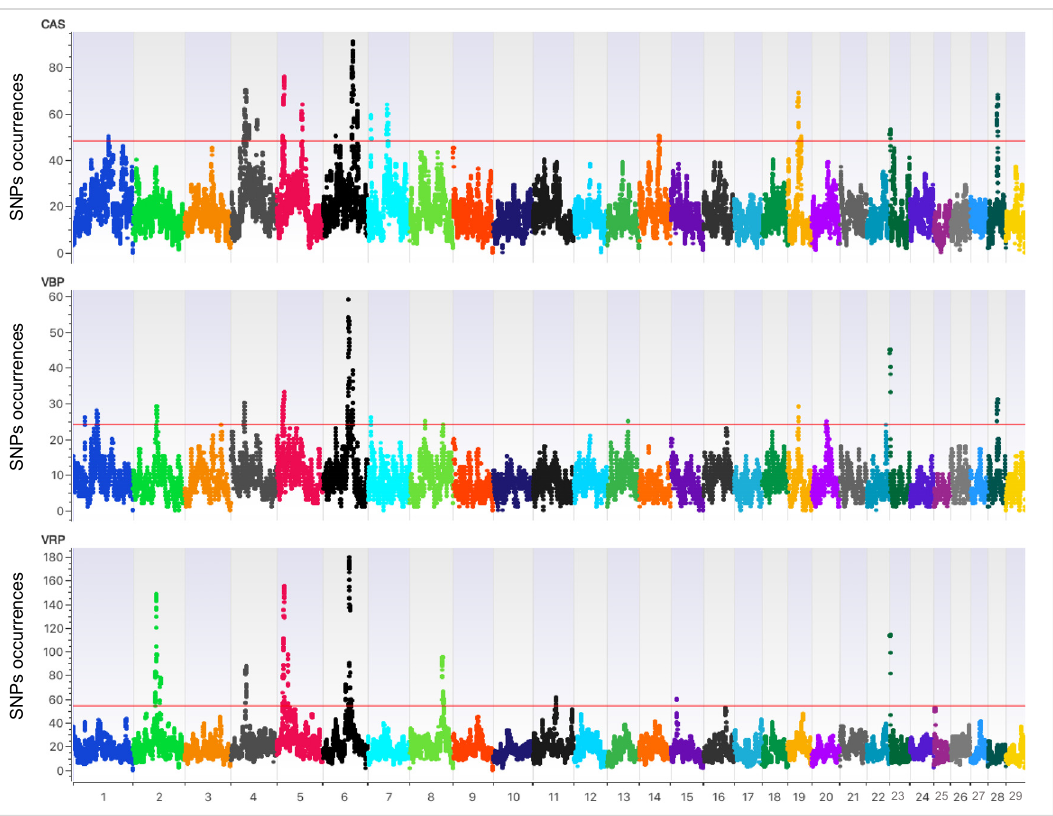
Figure 3. SNP occurrences for CAS, VBP, and VRP. The TOP_ROH were defined by the top 1% SNPs (TOP_SNPs) located above the threshold redlines set at the SNP occurrence values of 48, 24 and 54 for CAS, VBP and VRP, respectively.